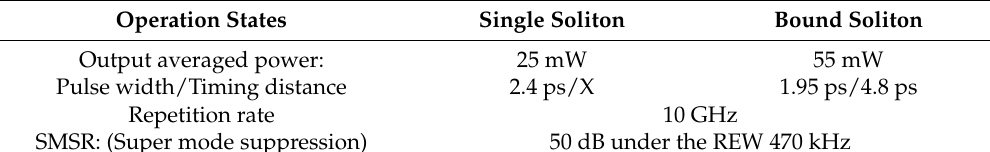
Table 1. Main output characteristics of the fiber laser.